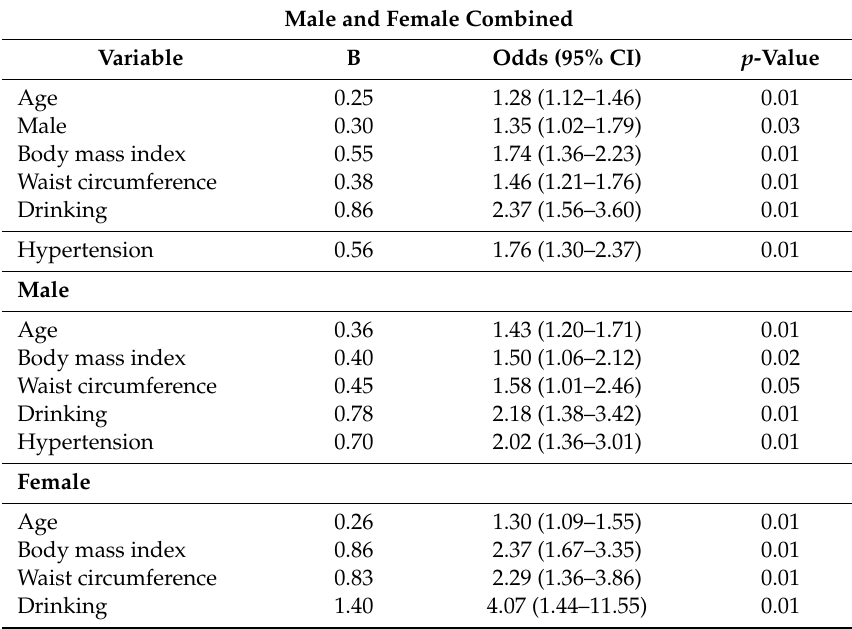
Table 3. Multivariate Analysis of People with